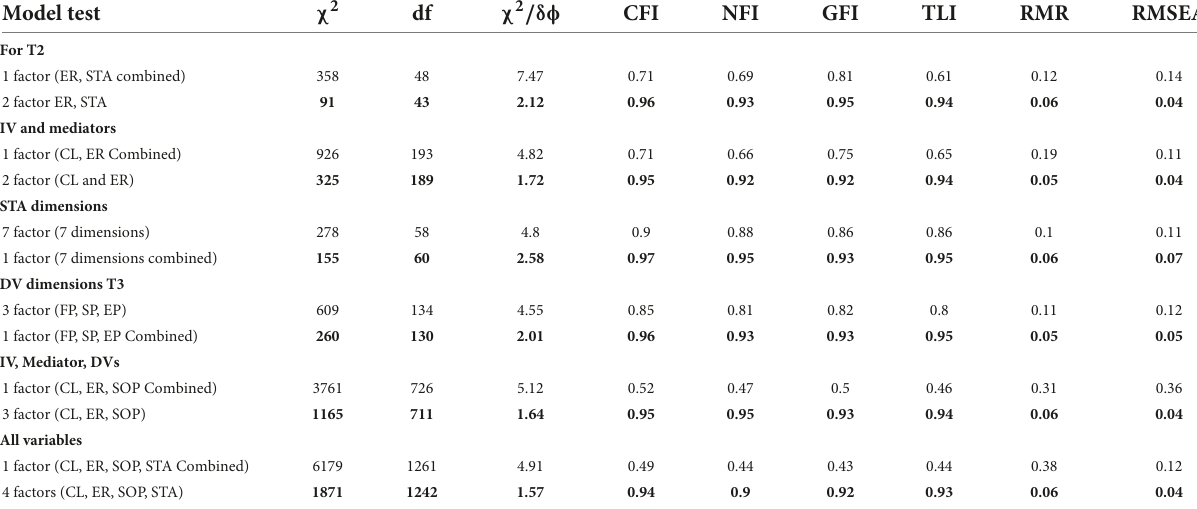
TABLE 3 Model fit indices for CFAs.